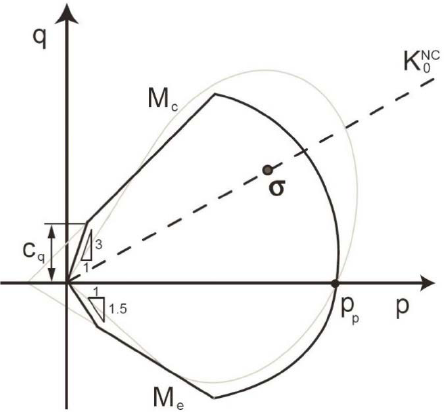
and M are the slopes of M-C criterion in c e